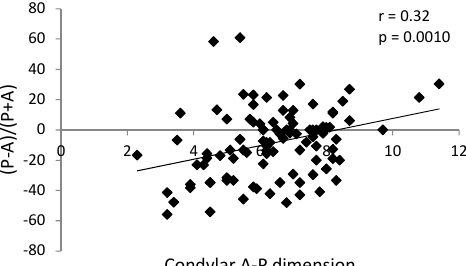
Figure 10. Graph presenting statistically significant positive correlation between condylar anteroposterior dimension and sagittal position of the condyle in the glenoid fossa in the group with TMJ reciprocal clicking.